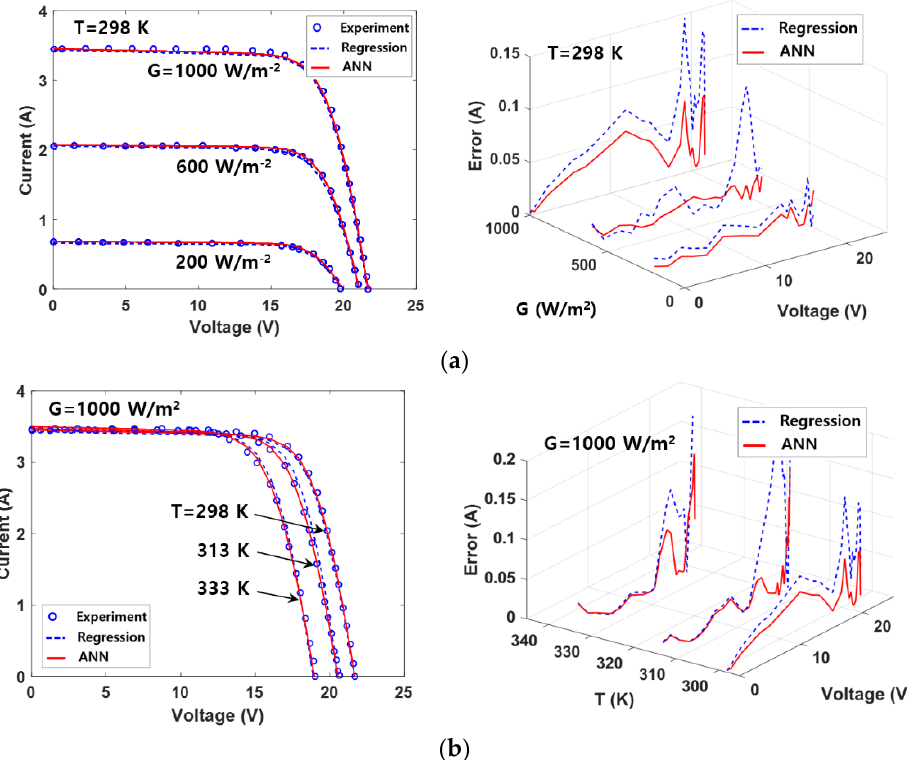
Figure 4. Statistical metrics for the five parameters in evaluating the accuracy of the regression model and ANN model: ( a ) RMSE and ( b ) MAPE.